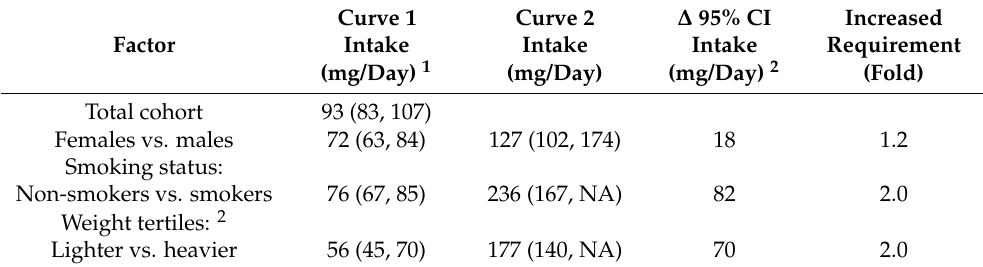
Table 8. Summary of vitamin C requirements from dose-concentration curves. Curve